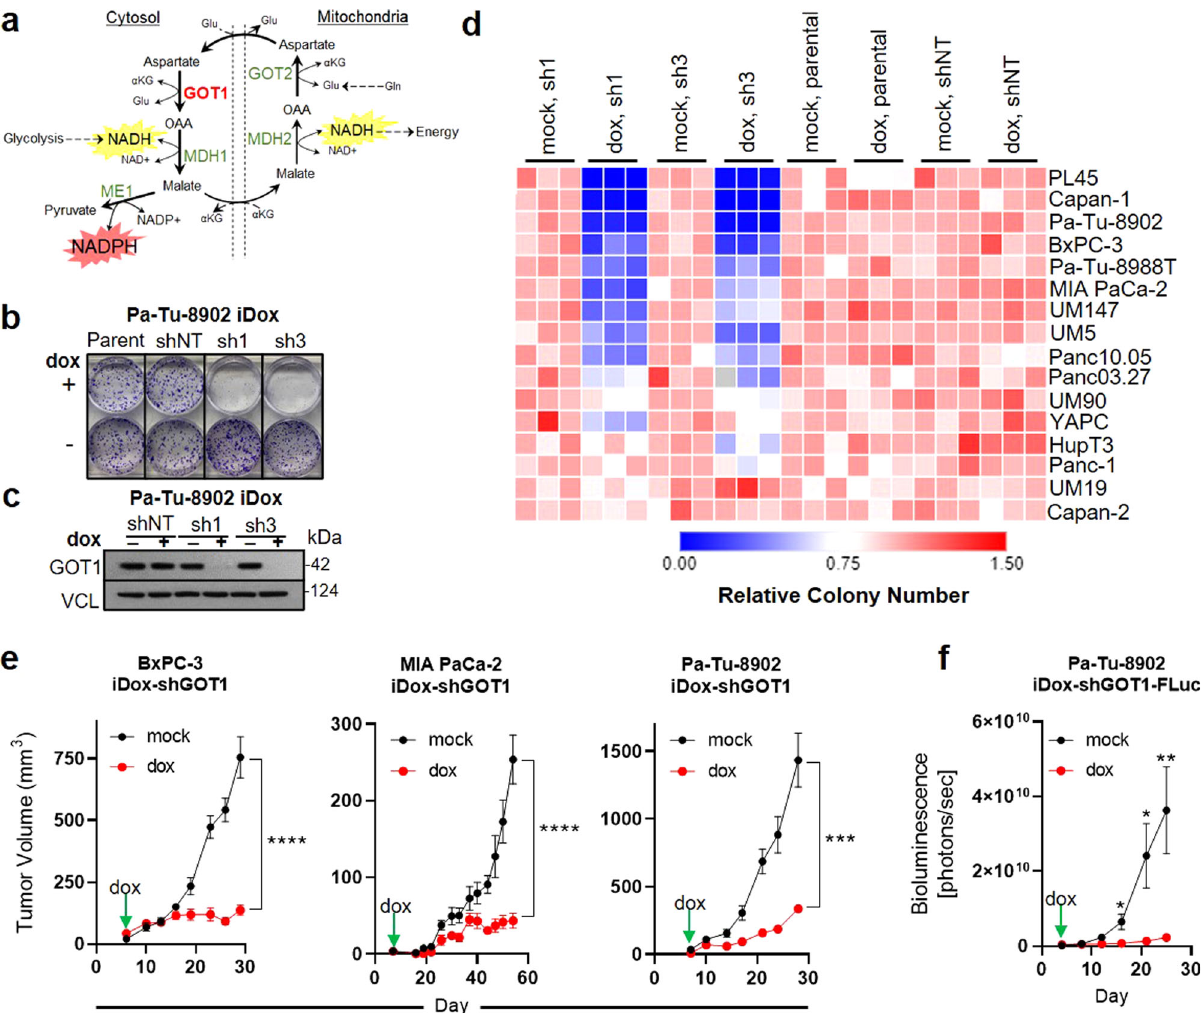
of Pa-Tu-8902 cells stably expressing iDox-shRNA constructs following 10 days GOT1 knockdown. shRNAs target the coding region of GOT1 (sh1), or the 3 ′ UTR region of GOT1 (sh3). Parental (parent) and scramble (shNT) conditions are also displayed. Vinculin (VCL) was used as a loading control. Immunoblot shown in ( c ) is representative of three independent experiments. d Relative colony number across a panel of PDA cell lines, n = 3 biological replicates. e Subcutaneous xenograft tumors from three PDA cell lines. Treatment with dox (red) or vehicle (black) (BxPC-3 mock-treated n = 8 mice; dox n = 6 mice; **** P = < 0.0001, MIA PaCa-2 n = 6 mice each group; **** P < 0.0001, Pa-Tu-8902 n = 6 mice each group; *** P = 0.0008). f Orthotopic xenograft tumor growth from Pa-Tu-8902 iDox-shGOT1 stable cells expressing fi re fl y luciferase (FLuc) n = 5 and n = 6 mice were used for vehicle and dox two independent experiments. Error bars represent mean ± SD. Source data are provided as a Source Data fi le. Gln glutamine, α KG alpha-ketoglutarate,